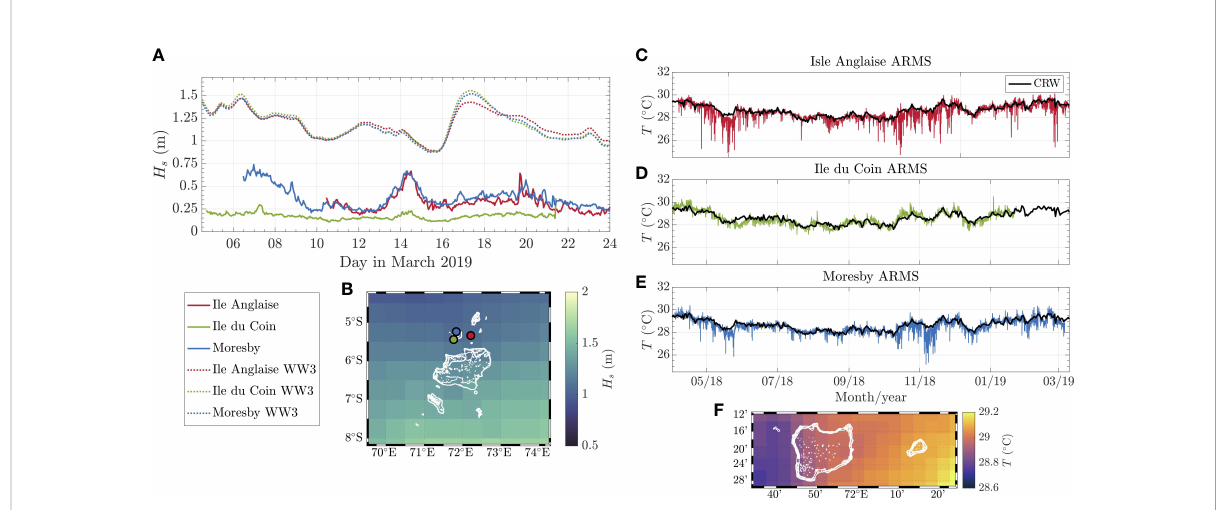
FIGURE 4 Comparison of in situ and ex situ data for wave heights (WaveWatch III model) and sea surface temperature (Coral Reef Watch (CRW) model) at each reef site. (A) Observed and estimated signi fi cant wave heights from the nearest WWIII cell during March 2019. (B) Visualisation of the WWIII resolution across the Chagos Archipelago marine-protected area (MPA), where one-coloured pixel represents a single value for the estimated wave height. (C – E) signi fi cant temperature values for individual reef sites (the black line represents CRW data, coloured lines represent in situ data). (F) Visualisation of the CRW resolution across the Peros Banos and Salomon atolls of the MPA, where one coloured pixel represents a single value for estimated